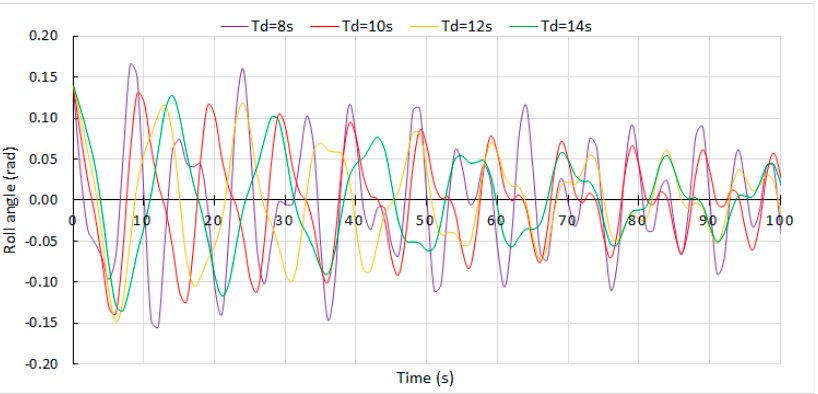
Figure 8. Simulation of the rolling angle for Tw = 5 s in the first moments.